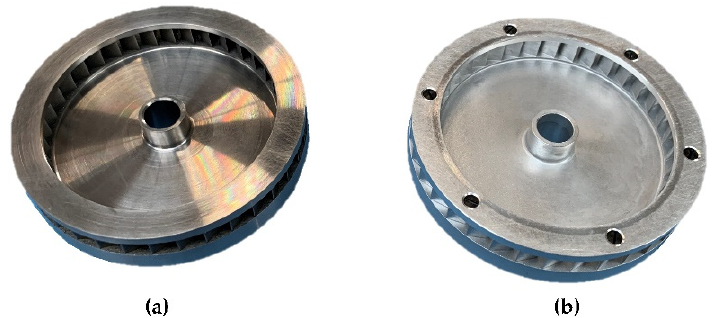
Figure 10. Comparison of the two different rotors: ( a ) 3D printed wheel ( Version 2b ); ( b ) Milled wheel ( Version 1 , 2a , and 3 ).